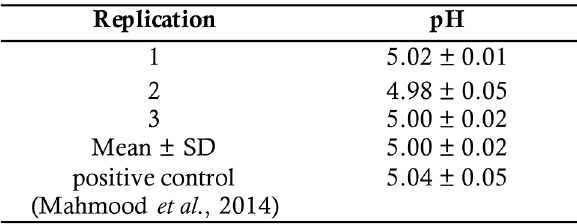
Based on the pH, the emulsion cream of green